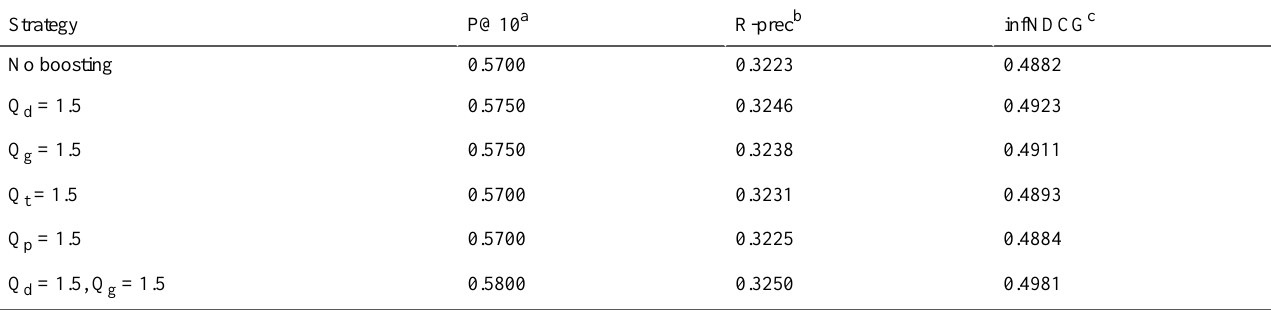
Table 3. Experimental results of query